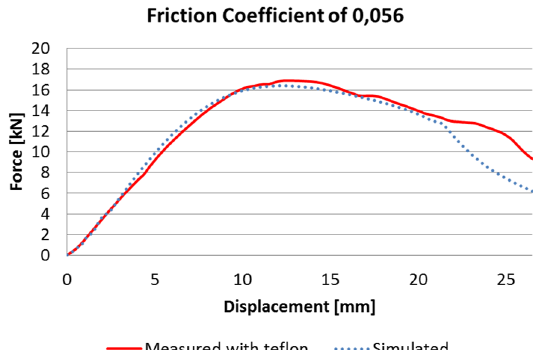
Figure 7. Comparison between the graphs generated by the simulation and those measured with